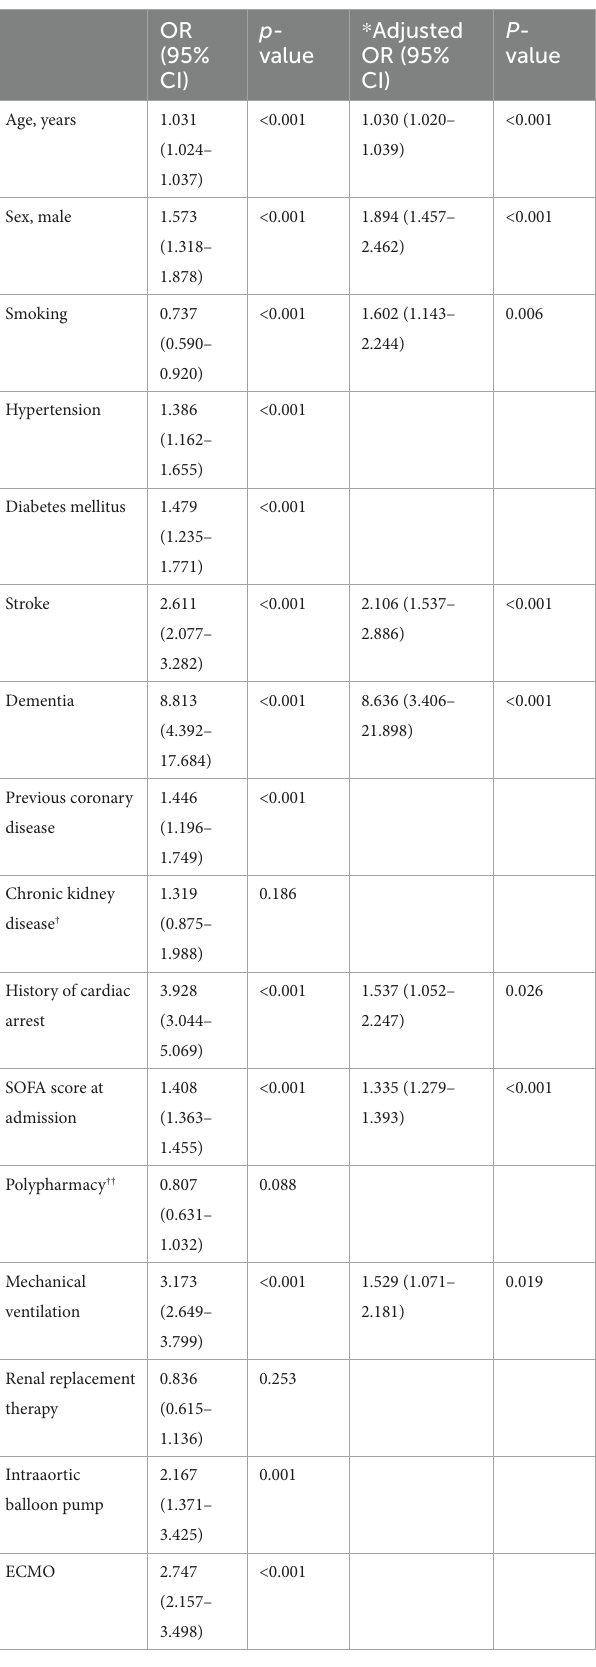
TABLE 3 Factors associated with